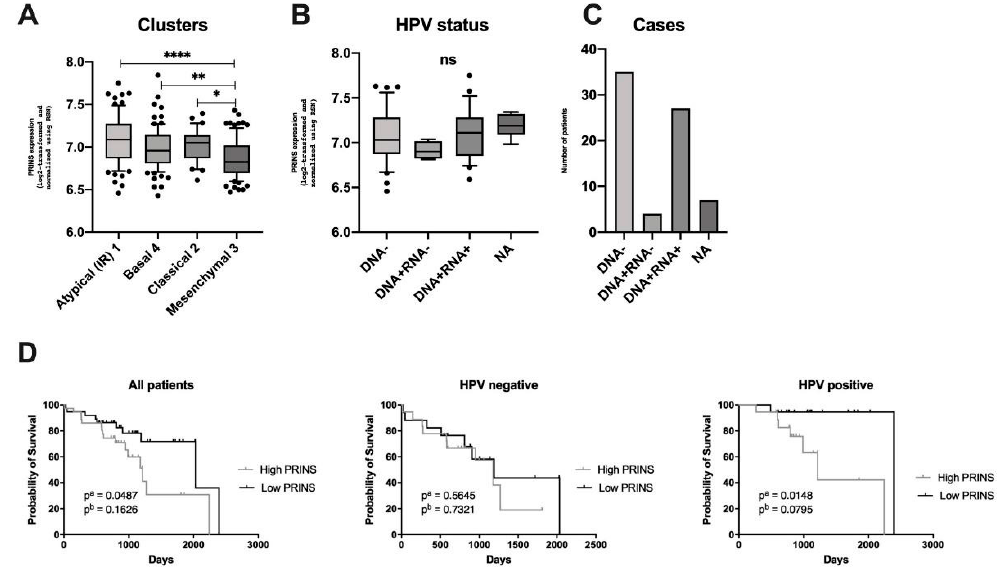
Figure 7. Characteristics of PRINS expression: ( A ) depending on type of cluster and ( B ) viral status in atypical (IR) 1 cluster with ( C ) number of patients’ cases in the atypical (IR) 1 cluster; ( D ) the OS of HNSCC patients depending on the PRINS expression levels in all cases, HPV( − ) and HPV(+) from the atypical (IR) 1 cluster. Based on the GSE65858 data set; one-way ANOVA test with post-test; ns: not significant, * p < 0.05, ** p < 0.01, **** p < 0.0001; p a —log-rank (Mantel-Cox) test, p b —Gehan-Breslow-Wilcoxon Test; p < 0.05 considered as significant.